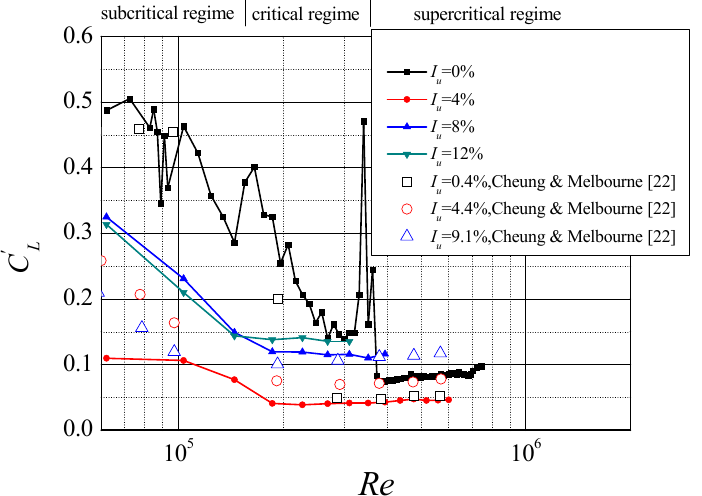
Figure 20 . Standard deviation of lift coefficient of circular cylinder in the turbulent flow. Figure 20. Standard deviation of lift coe ffi cient of circular cylinder in the turbulent